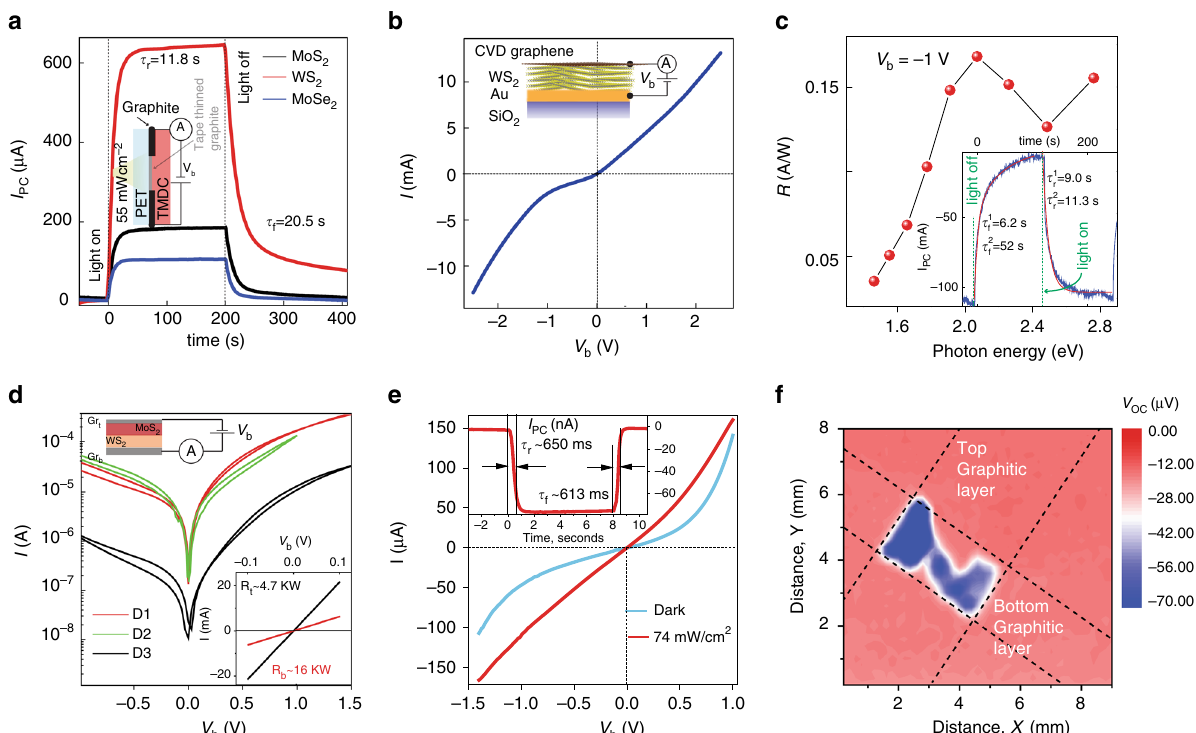
Fig. 2 Mechanically abraded fi lms for photodetection applications. a Temporal response for three planar photodetectors abraded onto PET substrates, consisting of graphite – MoS 2 (black), graphite – MoSe 2 (blue) and graphite – WS 2 (red). b I – V b for an Au – WS 2 – CVD graphene top electrode with device area of 1 mm × 1 mm and WS 2 fi lm thickness of ~300 nm. c Spectral dependence of the photocurrent for the device shown in b . Inset: shows the temporal response of the photocurrent with biexponential decay fi tted (red curve). d I – V b curves for three representative graphite – WS 2 – MoS 2 – graphite devices. Inset: I – V b curves for the top and bottom graphitic electrodes. e I – V b curves for the device D2 shown in d with (red curve) and without (blue curve) white light excitation of 74 mW/cm 2 . Inset: temporal response of the short circuit photocurrent at V b = 0 V. f Photovoltage map of one of our diode structures measured with a focussed laser ( E = 3.05 eV) with a power output of 0.5 mW and a spot size of diameter 5 µ